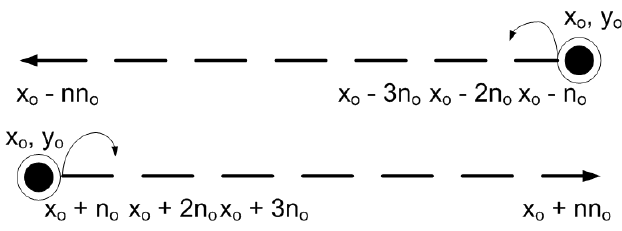
Figure 6. Specifications of linear mobility path followed by MSs.